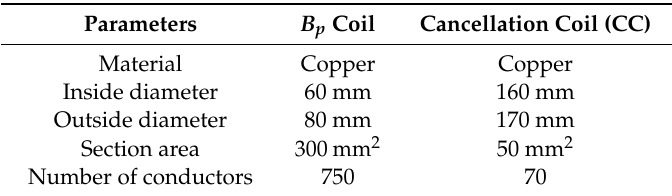
Figure 1. ( a ) Simulation model of the SR with B p coil and cancellation coils (CC) inside; ( b ) pulsed current through the B p coil during the simulation. Table 1. Parameters of the B p coil and the cancellation coil.